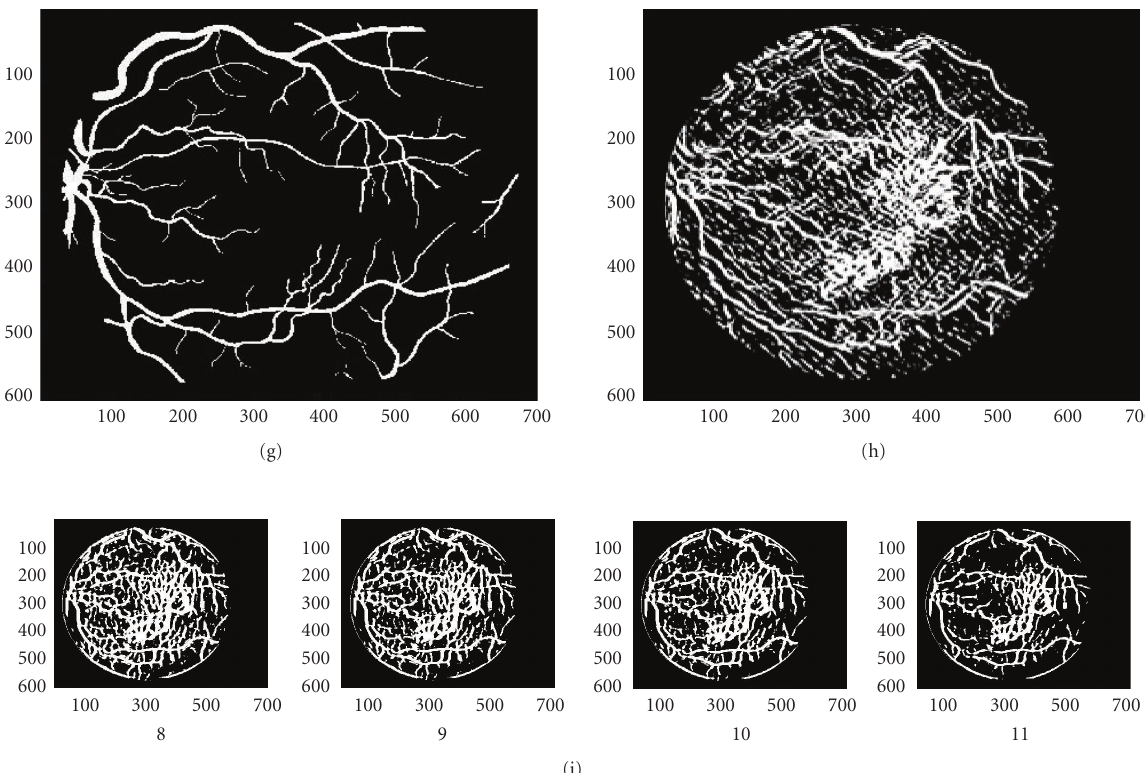
Figure 3: (a) Original fundus image for averagely traced major and peripheral network along with drusen. (b) Original fundus image ellipse corrected. (c) Binary vessel wall map. (d) Binary fundus image ellipse and drusen corrected. (e) Retinal vasculature with coarse and fine network based on VWP. (f) Retinal vasculature without VWP map using MIP. (g) Manually labelled ground truth vessel vasculature. (h) Redundant vessel vasculature produced using an augmented VM and double-sided GS-MG. (i) 2nd vessel network: Successive maps taken using di ff erent features and di ff erent sensitivities ( thresholds ). (8) Gradient homogeneity VMs. (9) Paired VP map and dominant gradient VM. (10) Increased vessel width allowed, lower gradient threshold and interpolated WPs. (11) Experimentally proved